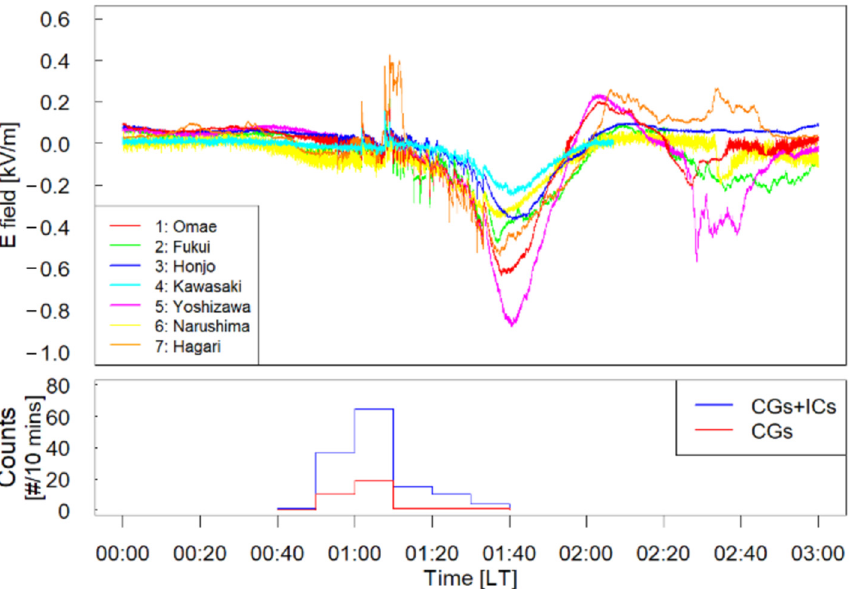
Figure 8. Top panel: Electrostatic waveforms near an isolated thundercloud during the period 0:00–3:00 (LT) on 27 August 2020. Bottom panel: Lightning occurrence obtained by JLDN during the period 0:40–1:40 (LT) (Adopted from [24]).